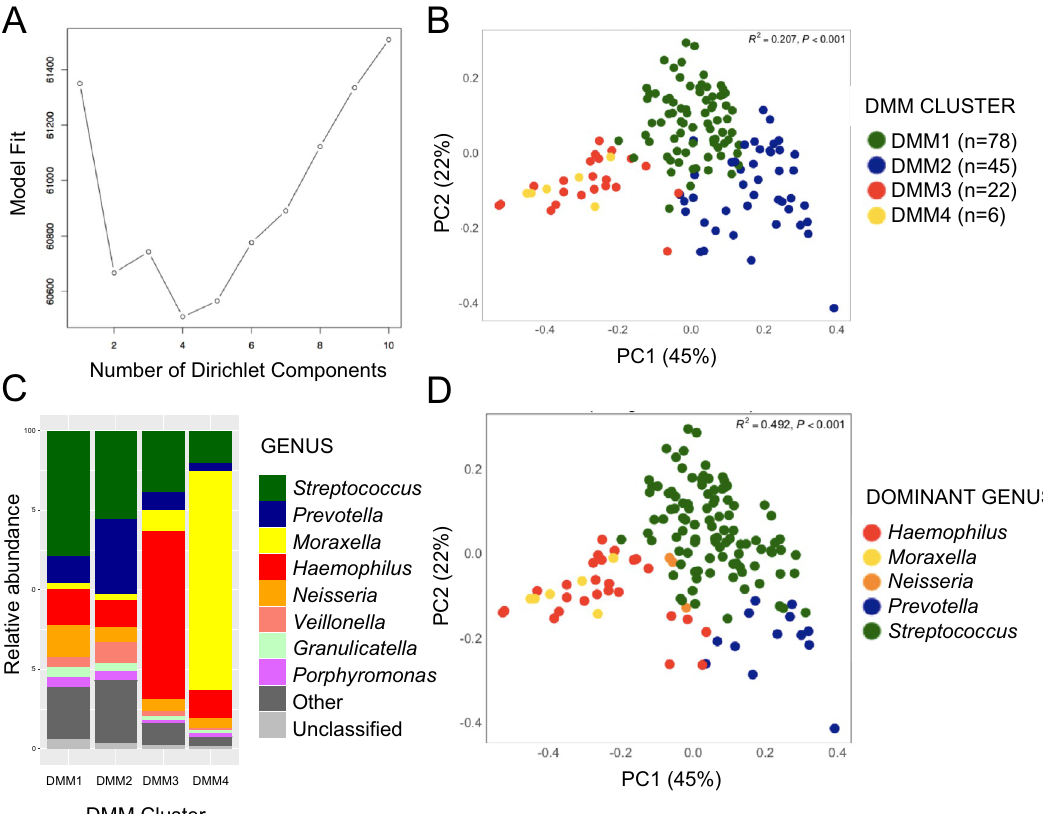
Figure 1. ( A ) LaPlace approximation of Dirichlet Multinomial Mixture Model fit indicating that four distinct sputum microbiota structures are evident in our pediatric cohort. ( B ) Distinct microbiota structures identified by Dirichlet multinomial mixture model (DMM) explain approximately 20% of variance in sputum microbiota composition (Weighted UniFrac). ( C ) Stacked bar graphs indicate that each DMM cluster is dominated by a distinct bacterial genus. ( D ) Distinct sputum microbiota dominated by Prevotella , Streptococcus , Haemophilus , Moraxella and Neisseria exist in the airways of children with HIV infection.